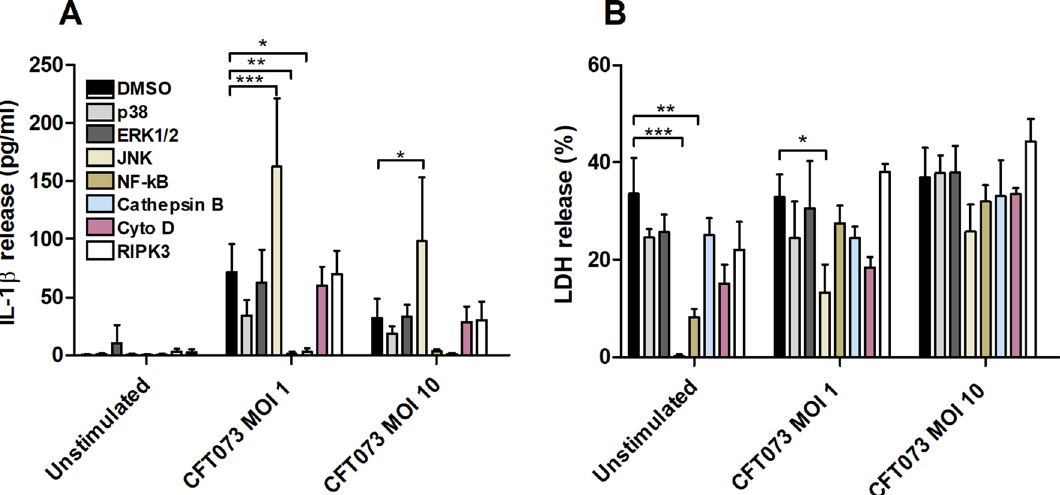
Figure 4. NF-κB and Cathepsin B are associated with UPEC-induced IL-1β release. Neutrophils were pre- incubated with DMSO (vehicle), JNK inhibitor SP600125 (10 µM), p38 MAPK inhibitor SB203580 (10 µM), ERK1/2 inhibitor PD98059 (10 µM), NF-κB inhibitor BAY 11–7082 (5 µM), cathepsin B inhibitor CA074 (100 µM), actin polymerization inhibitor cytochalasin D (Cyto D, 10 µg/ml), RIPK3 inhibitor GSK-872 (10 µM) for 1 h prior to infection with UPEC strain CFT073 for 6 h at MOI 1 or MOI 10 followed by analysis of IL-1β ( A ) and LDH release ( B ). Data are presented as mean ± SEM (n = 3 independent experiments). Asterisks denote statistical significance (* p < 0.05, **p < 0.01, ***p <